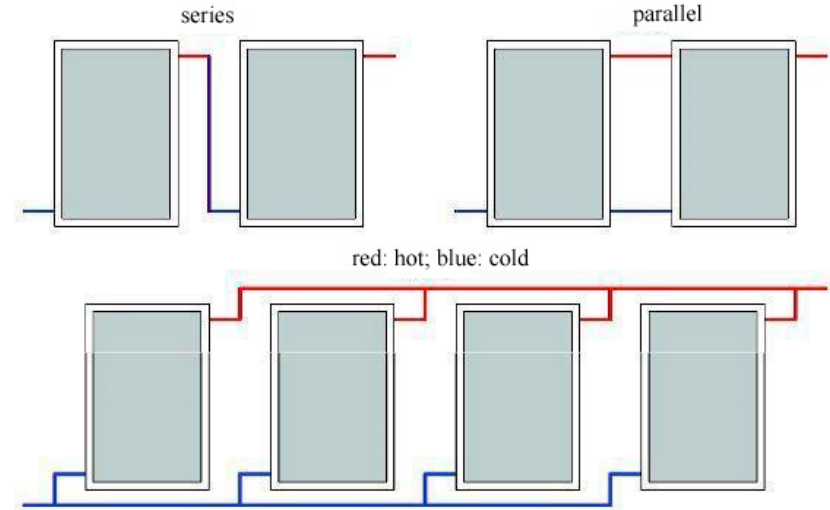
Figure 7. Solar thermal panels are connected in series and parallel [2].